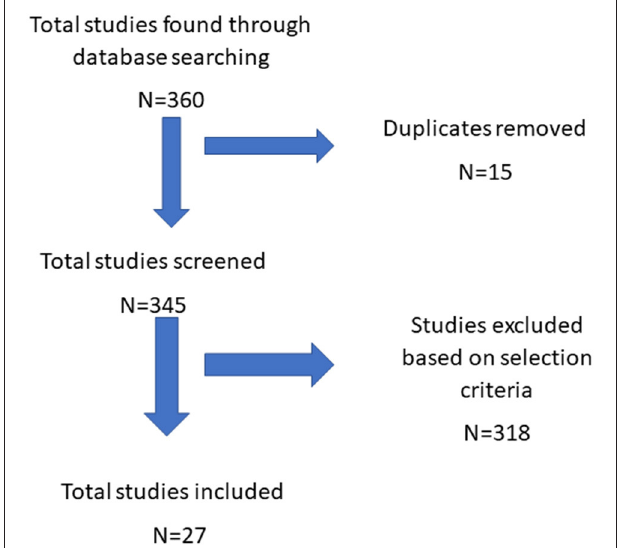
FIGURE 1 | Flowchart study selection